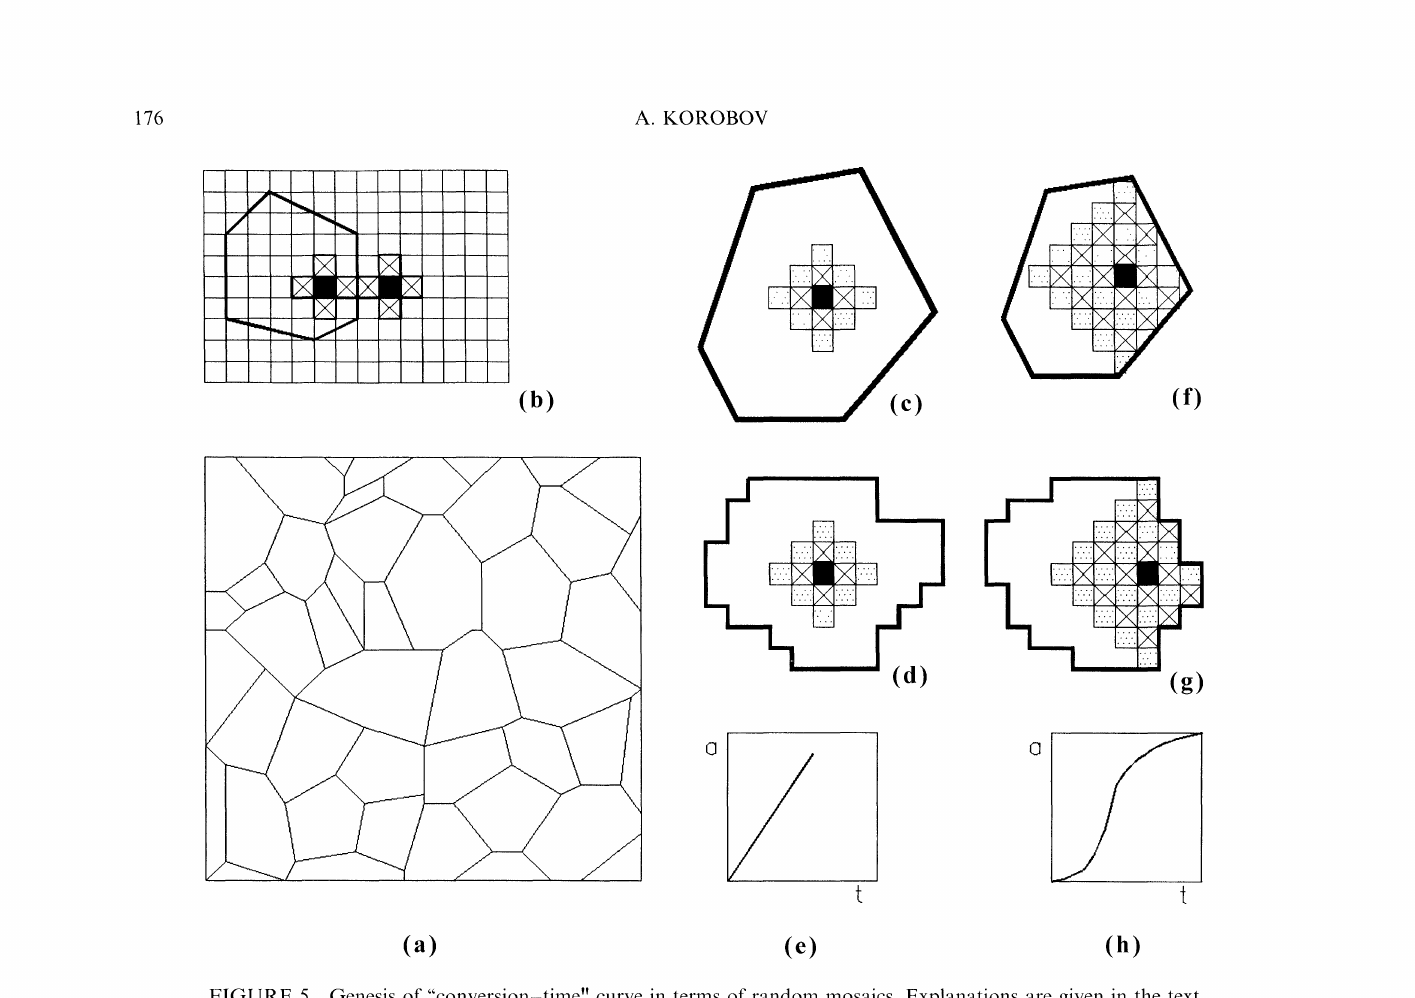
FIGURE 5 Genesis of "conversion-time curve in terms of random mosaics. Explanations are given in the